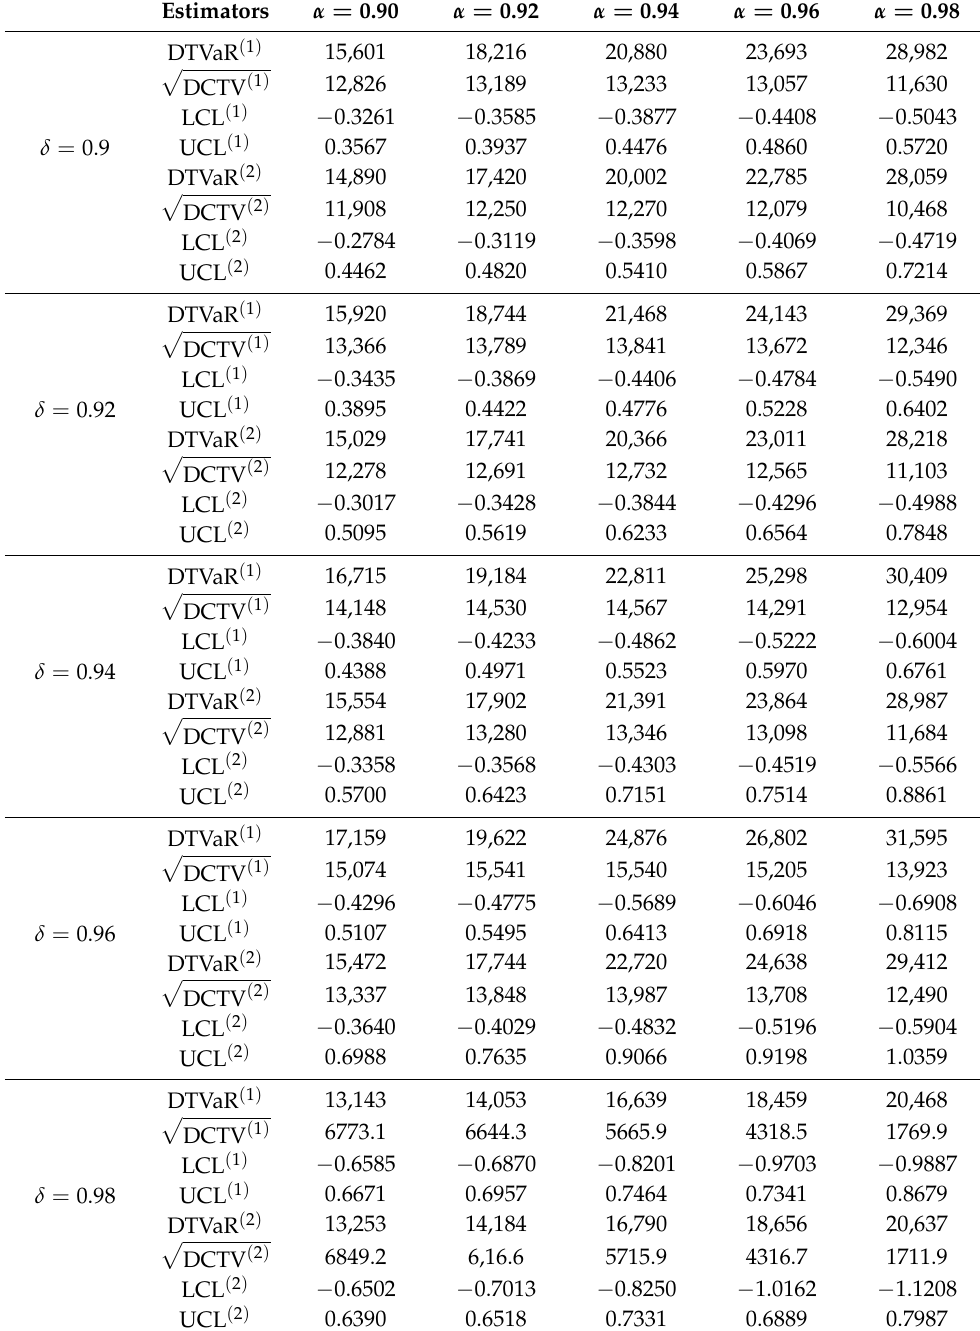
( δ ,0 ) ( X | Y ; C ) estimates and bootstrap confidence Table 3. DTVaR ( α ,0 )